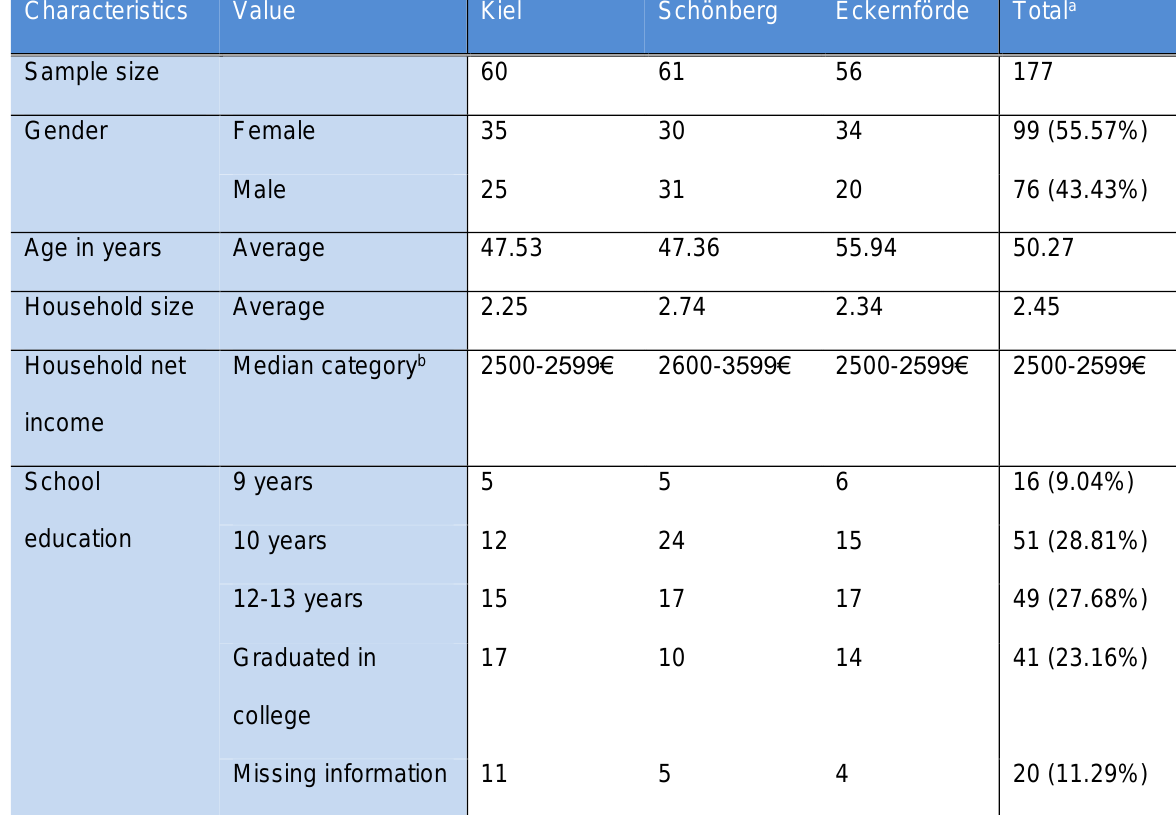
Table S4 : Distribution of characteristics over samples of respondents in surveys conducted at Kiel, Schönberg, Eckernförde and in total. Absolute numbers are given if not stated